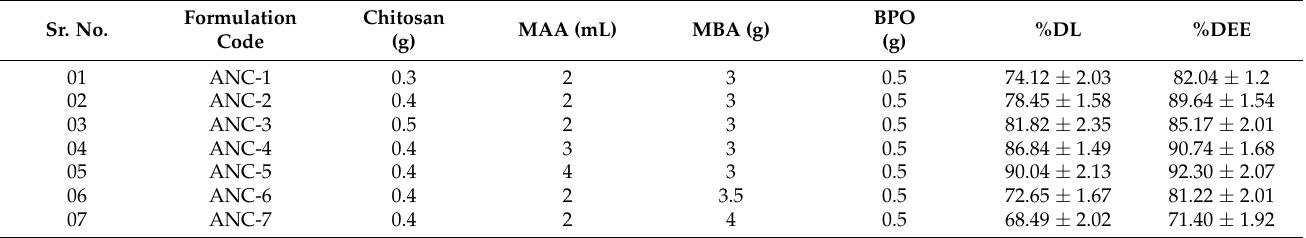
Table 5. Composition of chitosan (polymer), MAA (monomer), MBA (cross-linker), BPO (initiator), solvents (water and ethanol), percent drug loading (%DL), and percent drug entrapment efficiency (%DEE) in nanomatrices